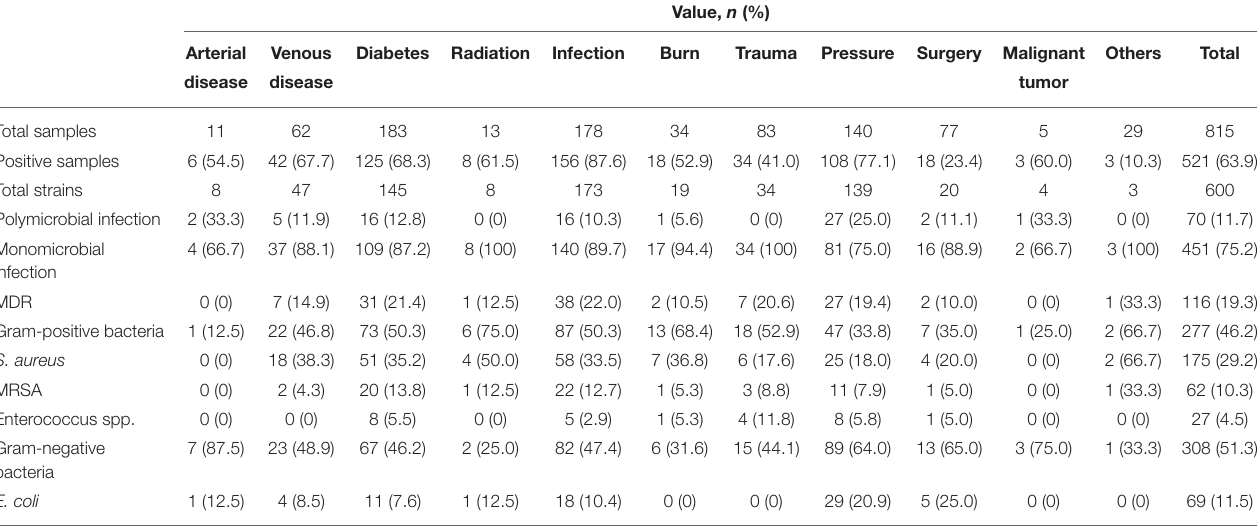
TABLE 3 | The distribution of common pathogenic bacteria in wounds of different causes. Value, n (%) Arterial Venous Diabetes Radiation Infection Burn Trauma Pressure Surgery Malignant Others Total disease disease